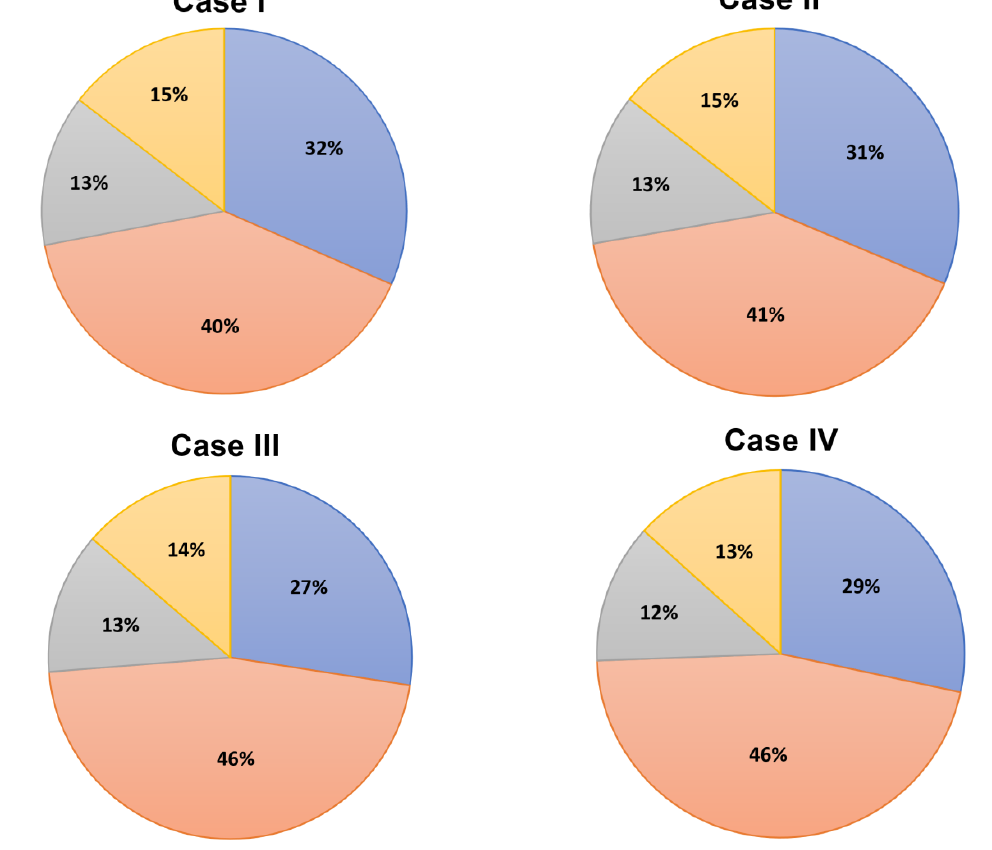
Figure 10. The breakdown of net present value (NPV) revenue (AUD) over 20 years for the VPP in the cases I to IV, defined at the beginning of this section.